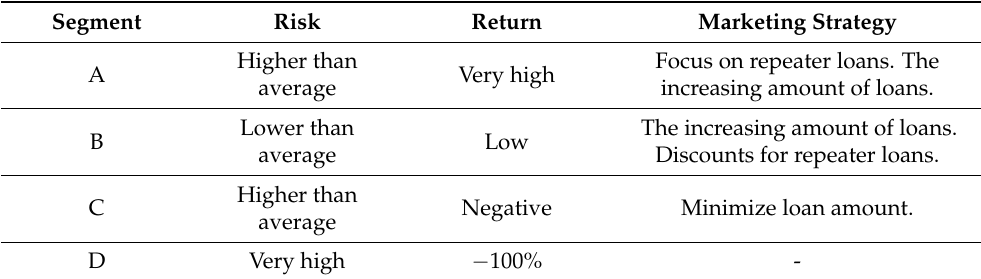
Table 2. Risk, return, and marketing in